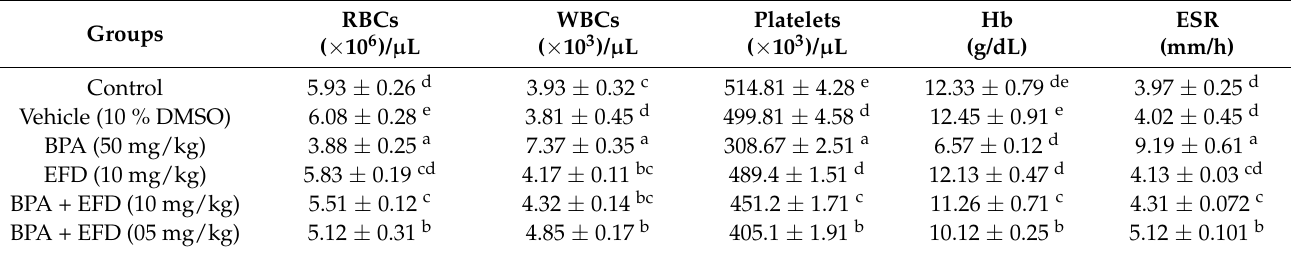
Table 3. Effect of EFD on hematological